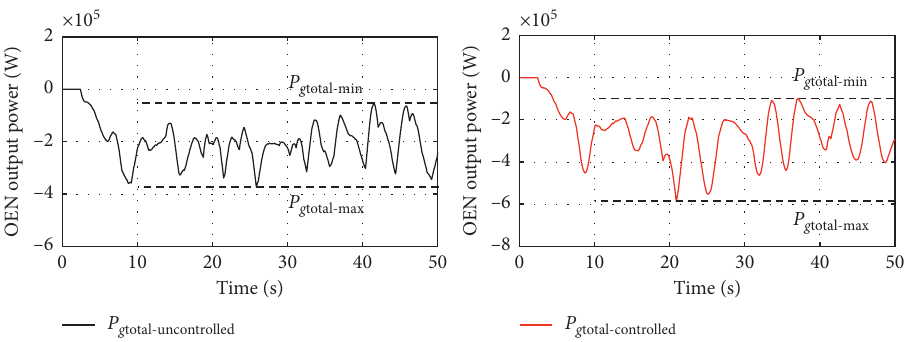
Figure 12: Total output power for uncontrolled and MPPT-controlled OWC-OEN.